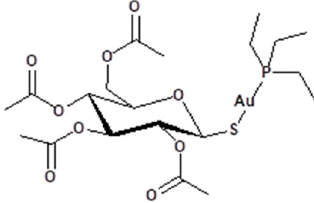
Figure 1. Auranofin is an anti-rheumatic agent with favorable anticancer